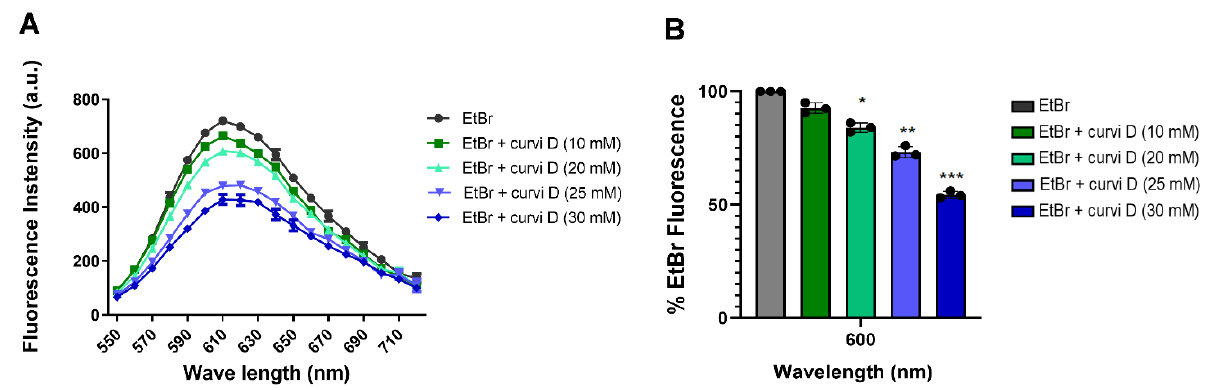
Figure 7. Curvicollide D intercalates into DNA. Ethidium bromide displacement assay using a double stranded DNA plasmid. Increasing concentration of curvicollide D (10 µ M to 30 µ M) were used to determine ( A ) the fluorescence intensity (arbitrary unit (a.u)) from 550 nm wavelength to 720 nm, and ( B ) the percentage of EtBr fluorescence at 610 nm determined in ( A ). Mean values of triplicates and corresponding standard deviations are shown. Statistical significance between control (EtBr) and each treatment was stimated using Student’s two-tailed t -test. p -Values were expressed as follows: * p < 0.05; ** p < 0.01 and *** p < 0.001.